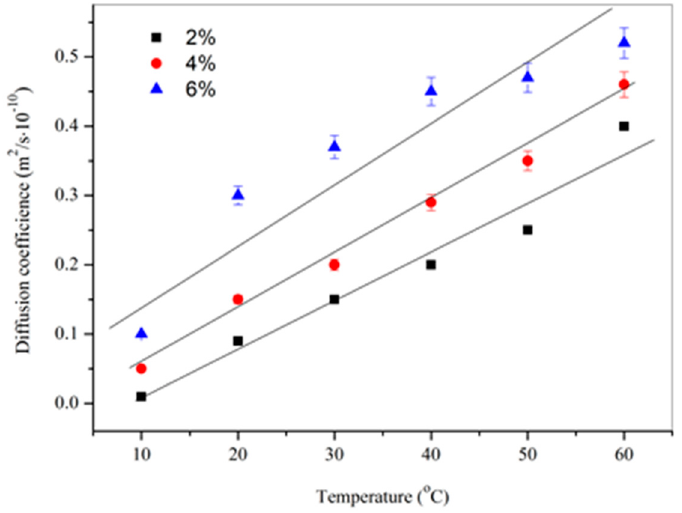
Figure 8. Diffusion coefficient values of microcapsules (sample of M-1) in bitumen with contents of 2%, 4% and 6% under a temperature range of 10 °C–60 °C.